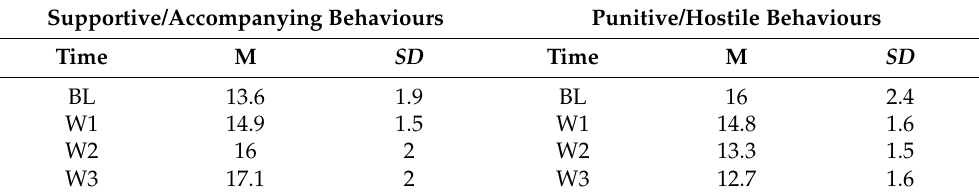
Table 4. Descriptive statistics for supportive/accompanying and punitive/hostile behaviours.